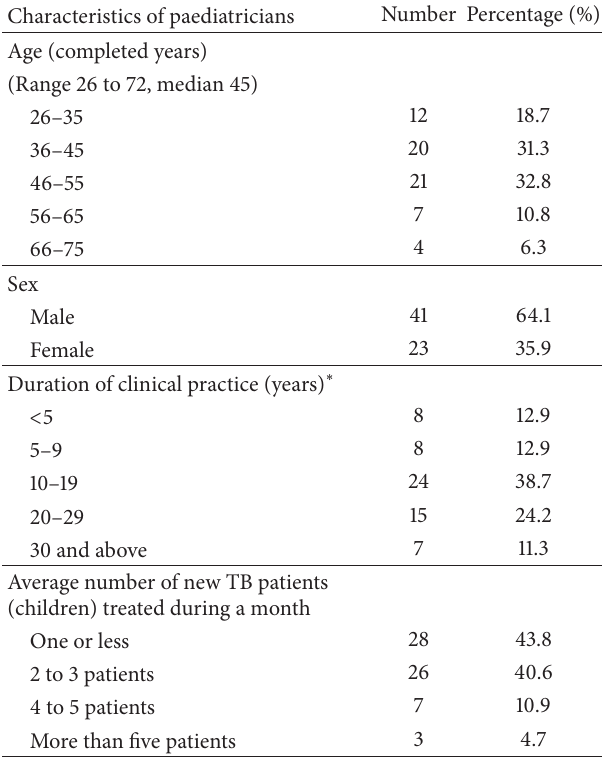
Table 2: Characteristics of paediatricians ( 𝑁 = 64 ). Characteristics of